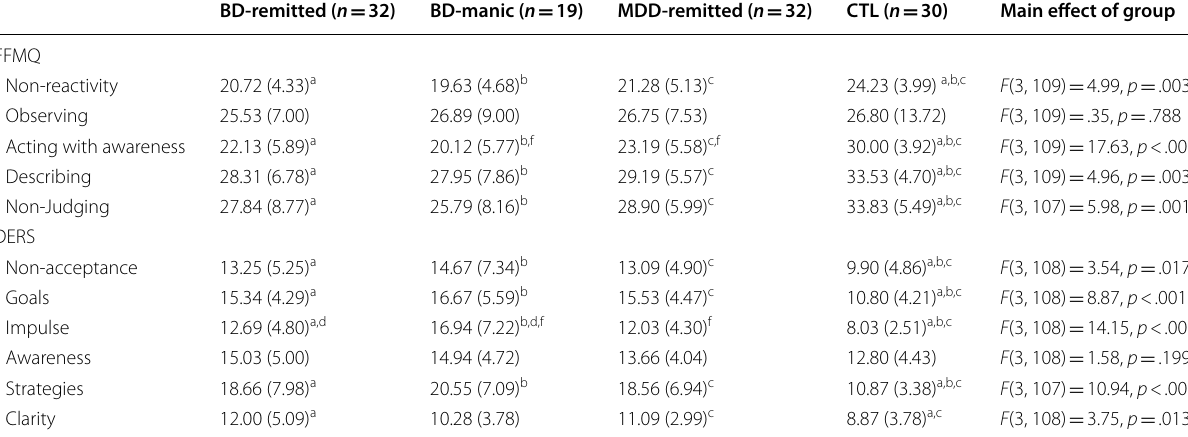
Table 2 Descriptive statistics for FFMQ and DERS by diagnostic